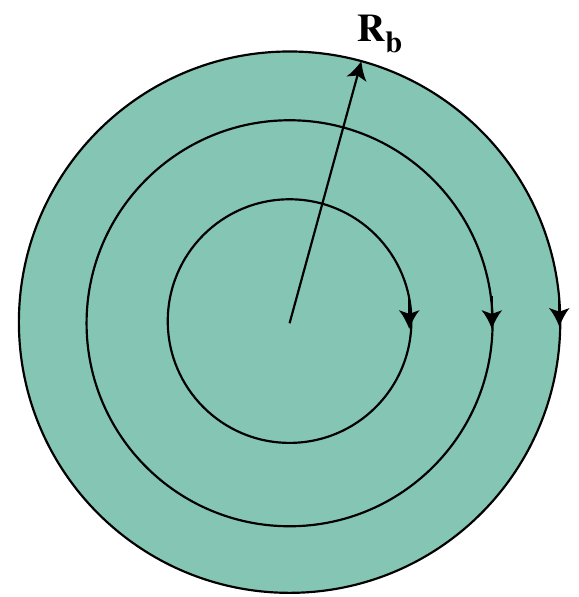
FIG. 1. (Color) Distribution with linear force. Arrows and circles show particle velocities and trajectories, respectively. The filled area shows the region of uniformly distributed